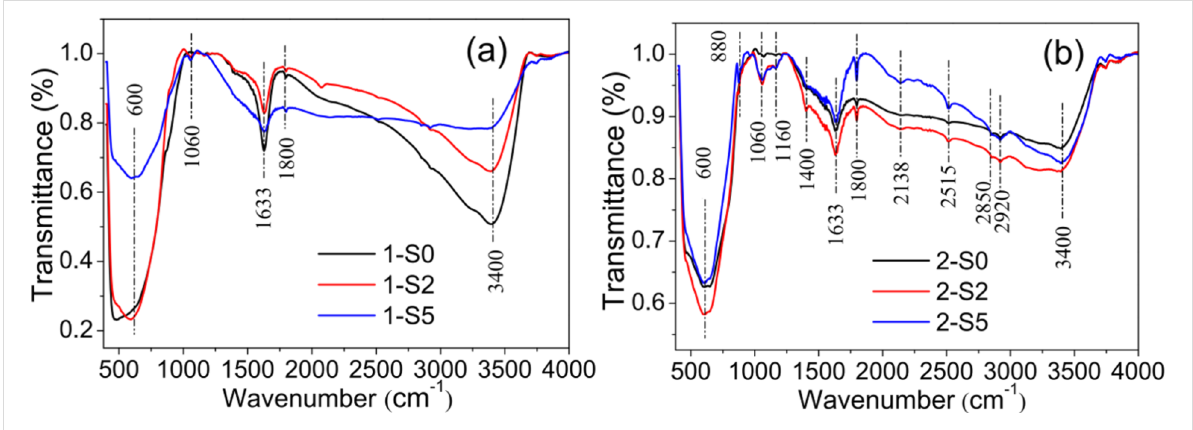
Figure 3: The FTIR spectra of 1-S0, 1-S2 and 1-S5 (a); 2-S0, 2-S2 and 2-S5 (b).